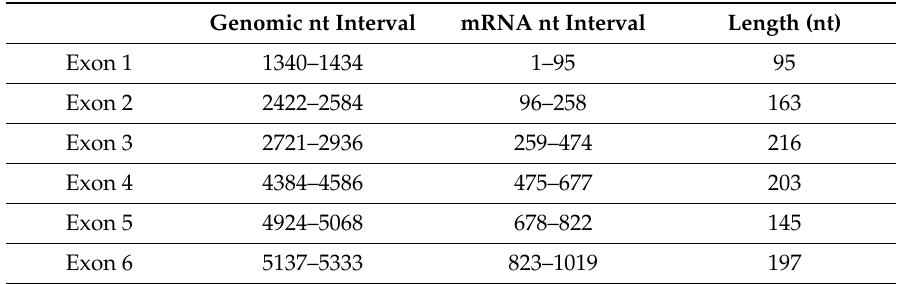
Figure 1. Schematic organization of BsC3a / C5aR gene. Exons are represented by boxes and introns by lines. Numbers refer to the length of the nucleotide sequence. Table 1. Distribution of exons and their transcript counterparts in the genome and transcriptome sequences of BsC3a / C5aR, respectively.